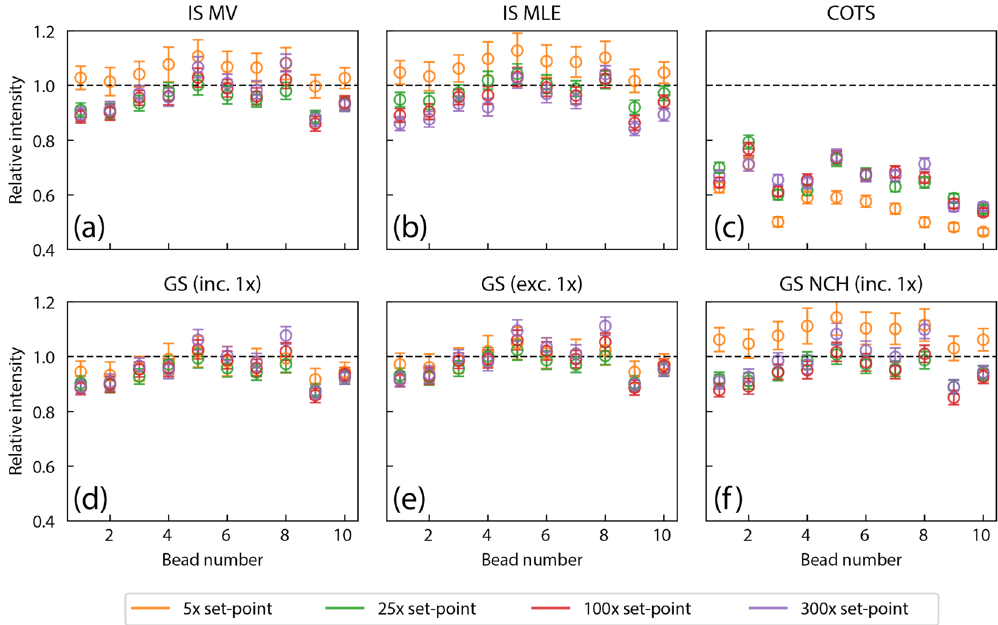
Figure 5. Summary of consistency results for a collection of beads. Plots show the results of localization fitting for ten beads imaged together in the same field of view, scaled to the mean intensity from the 1× measurements. Intensity values from the 5× dataset are outliers for all calibration methods except the two gain-series. The gain- series methods show consistency across gain set-points for all beads